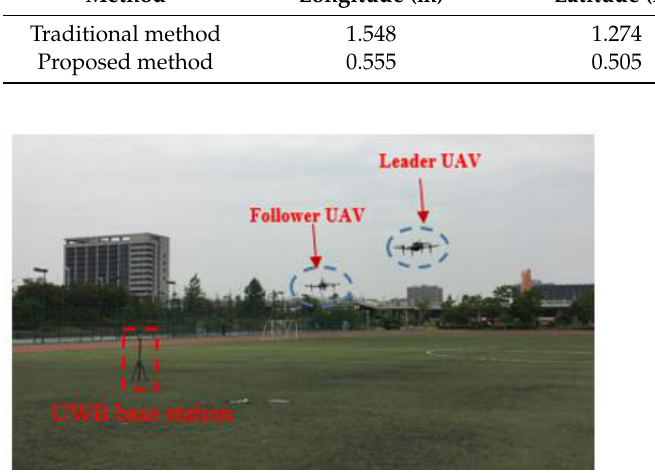
Figure 6. Two UAVs autonomous flight cooperative localization experiment.